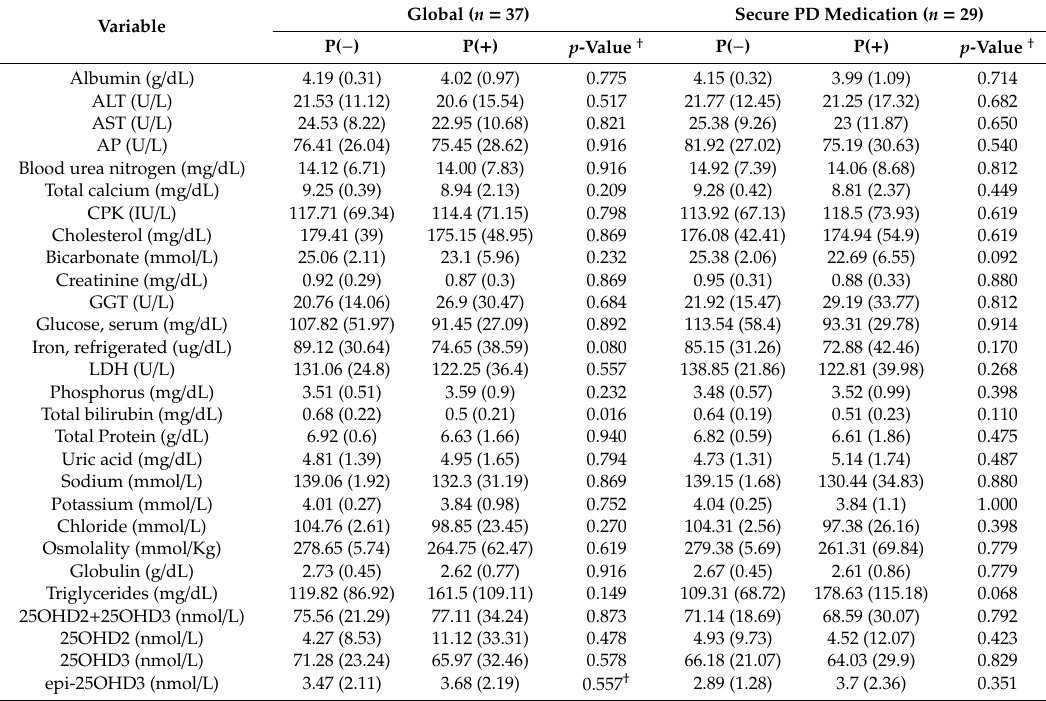
Table 3. Standard biochemical levels of PD patients with periodontitis and without periodontitis.